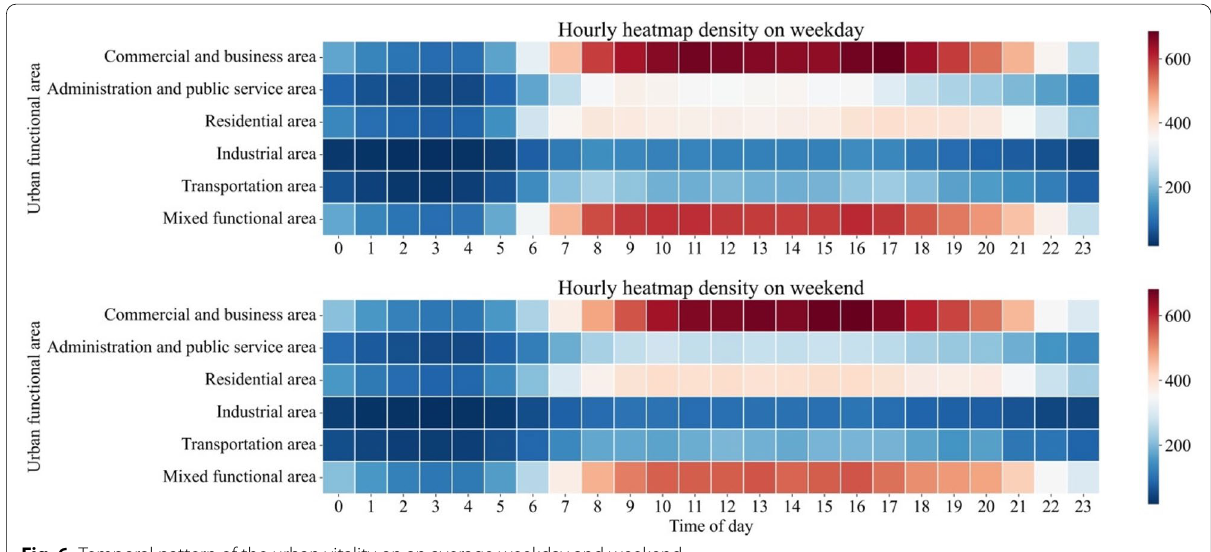
Fig. 6 Temporal pattern of the urban vitality on an average weekday and